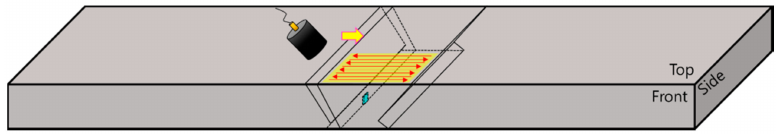
Figure 21. Experimental setup for detecting defects in welded specimens of di ff erent metals using ultrasonic angular incidence through the carbon steel and buttering layer.